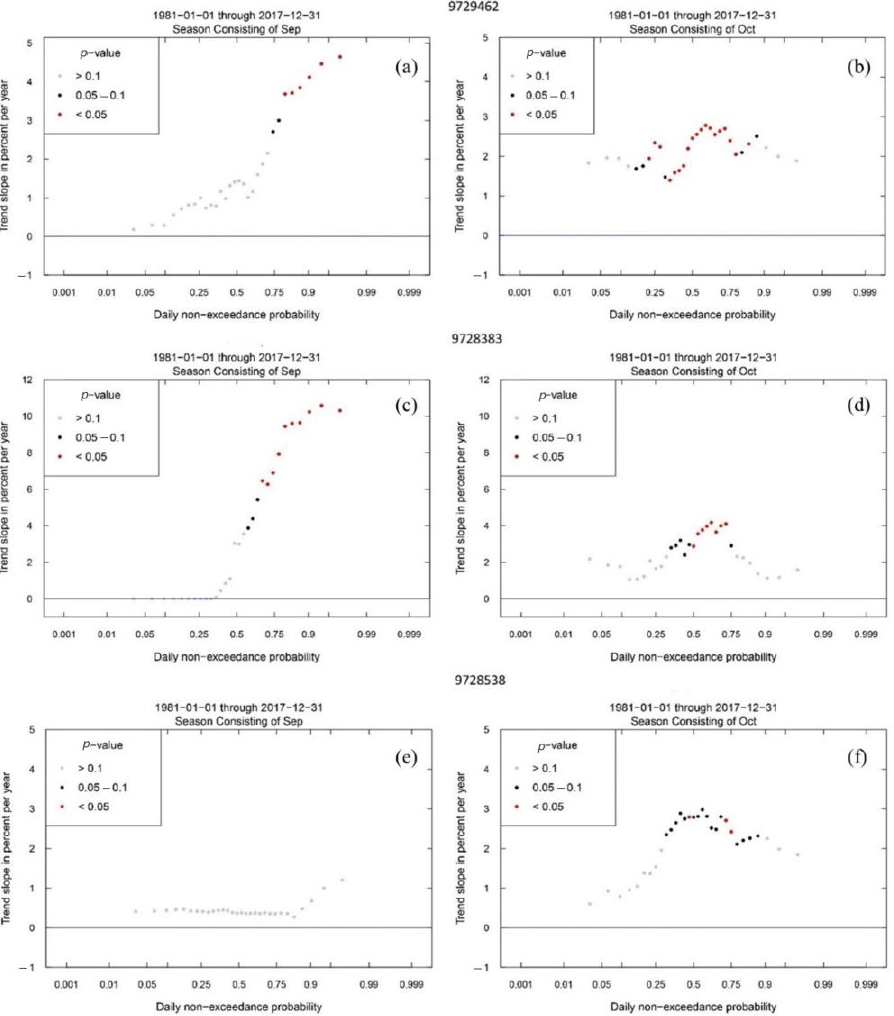
Figure 7. Quantile-Kendall plots showing 1981–2017 trends in simulated discharge for September (left column) and October (right column) in the ( a , b ) PINUP, ( c , d ) TITAR, as well as ( e , f ) MREMA sub-basins. The plots show the magnitude of the trends across the range from low to high flows (left side to right side, respectively) for each sub-basin, based on daily discharge data of ( a , c , e ) September and ( b , d , f ) October. The color represents the p -value for the Mann-Kendall test. Red indicates a trend that is significant at 0.05 level (95% confidence). Black indicates an attained significance between 0.05 and 0.1 (95% and 90% confidence). Grey dots indicate trends that are not significant at the 0.1 level (90% confidence).